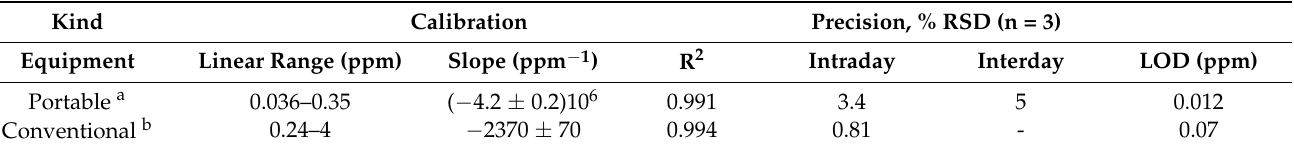
Table 3. Several figures of merit of portable bynomial sensor luminometer and conventional procedure: in solution and lab equipment. a by using the sensor b in